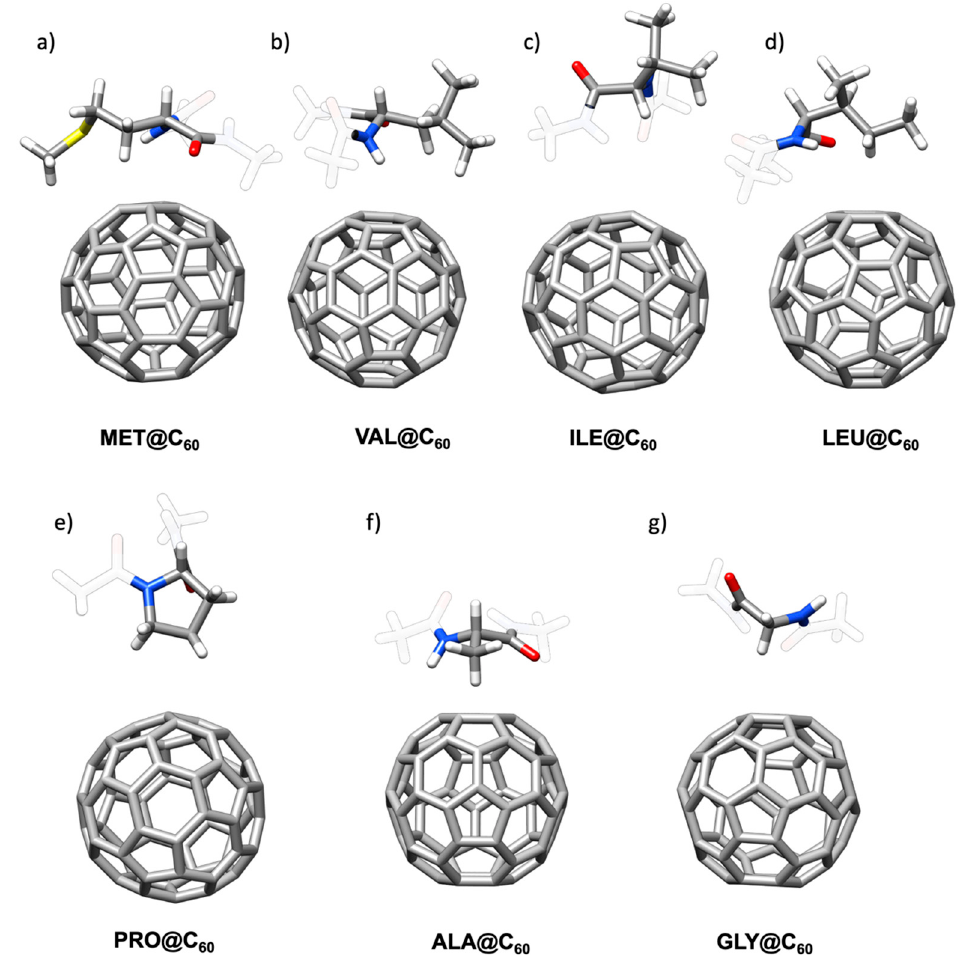
Figure 6. Snapshots from the MD of the interactions of hydrophobic amino acids ( a ) Met, ( b ) Val, ( c ) Ile, ( d ) Leu, ( e ) Pro, ( f ) Ala and ( g ) Gly with C 60 . For each amino acid, the most interactive configuration is shown.